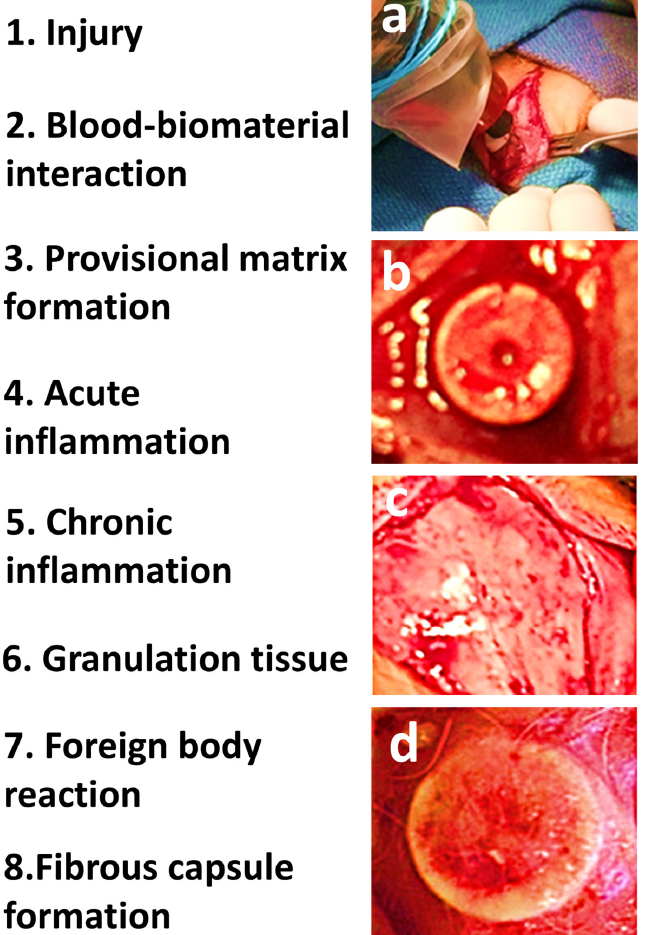
Figure 1. The sequence of host reactions upon implantation of biomaterial device in vivo